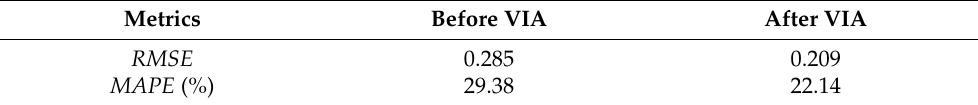
Table 7. Comparison of performance metrics of after variable importance analysis.